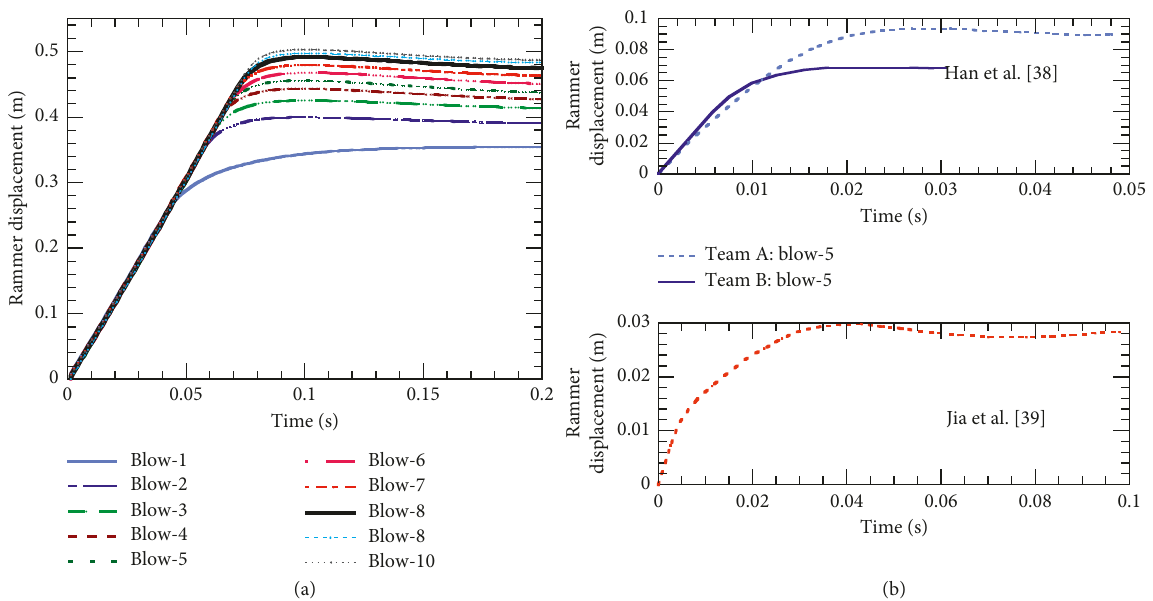
Figure 5: Hammer displacement over time in different studies: (a) displacement in this paper; (b) displacement in [38, 39].